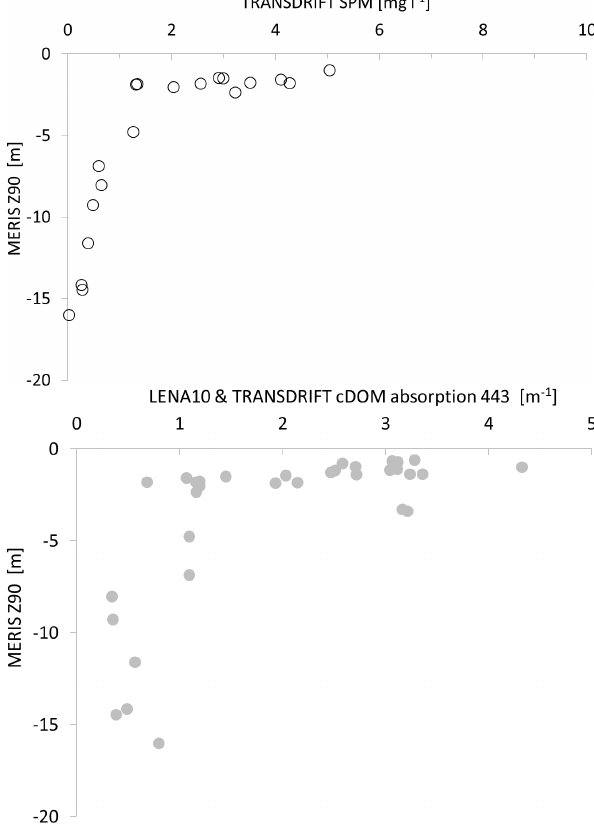
Figure 6. (a) In situ SPM (TRANSDRIFT data from 9 to 20 September 2010) vs. MERIS C2R_Z90 (calculated from the MERIS acquisition on 7 September 2010, n = 21). All selected MERIS values are without cloud contamination. (b) cDOM 443 (TRANSDRIFT & LENA2010) vs. MERIS C2R_Z90. L10C2R_Z90 was taken from the MERIS concomitant acqui- sitions closest in time to the sampling: 3, 4 and 6 August 2010 were matched with LENA2010 cDOM 443 , n = 7. TRANS- DRIFTC2R_Z90 was taken from 7 September 2010 and matched with cDOM 443 (9 to 20 September 2010) using all available pixels within relatively homogenous environments, but of satellite acqui- sition 2 to 5days later, n =